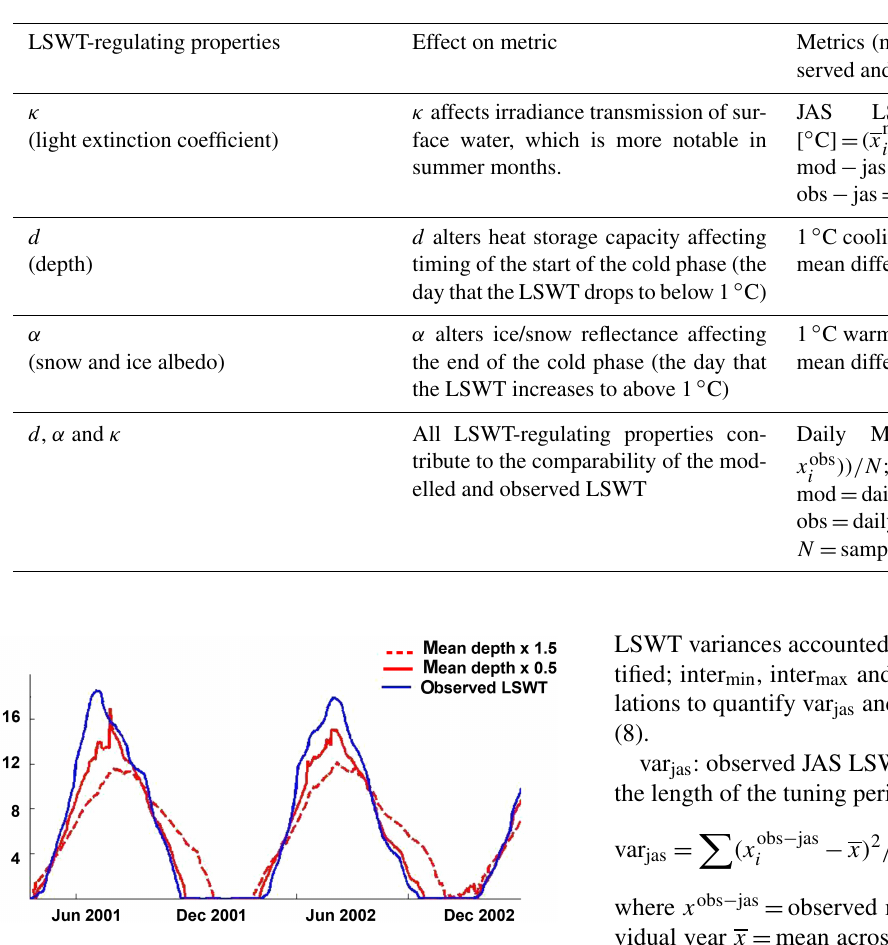
Figure 9. Effect of depth on the lake surface water temperature (LSWT) for Lake Ladoga, Russia (61 ◦ N 31 ◦ E) (mean depth 52m), showing that when modelled at a greater depth, the lake cools later and the maximum LSWT is